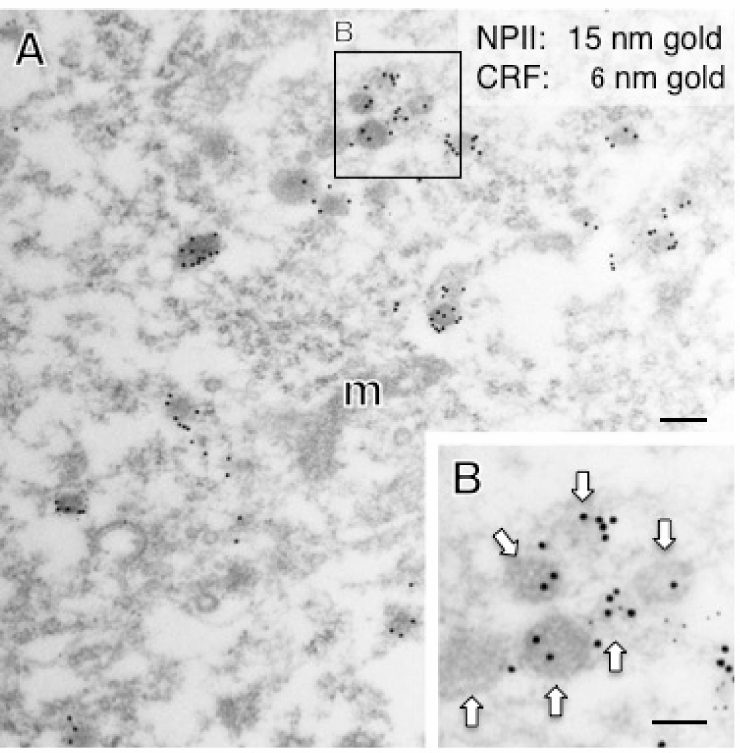
Figure 11. Double-label immunoelectron microscopy for vasopressin-associated neurophysin (NPII) and corticotropin-releasing factor (CRF) in the paraventricular nucleus (PVN) of the hypothalamus in a macaque monkey. ( A ) In the cell body of a possible parvocellular vasopressin neuron, many dense-cored neurosecretory vesicles located in the cell body were doubly immunopositive for CRF (6-nm gold particles) and NPII (15-nm gold particles). The outlined area in ( A ) is enlarged in ( B ). Scale bars, 200 nm, and 100 nm in the enlarged image. Arrows indicate dense-cored neurosecretory vesicles. m,